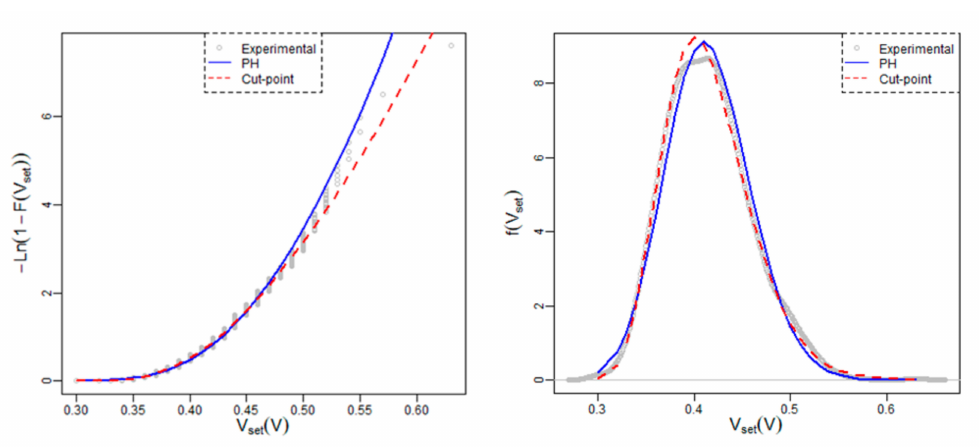
Figure 6. Cumulative hazard rate ( left ) and probability density function ( right ) for 1000 set voltages and the corresponding PH and cut-point PH fit.